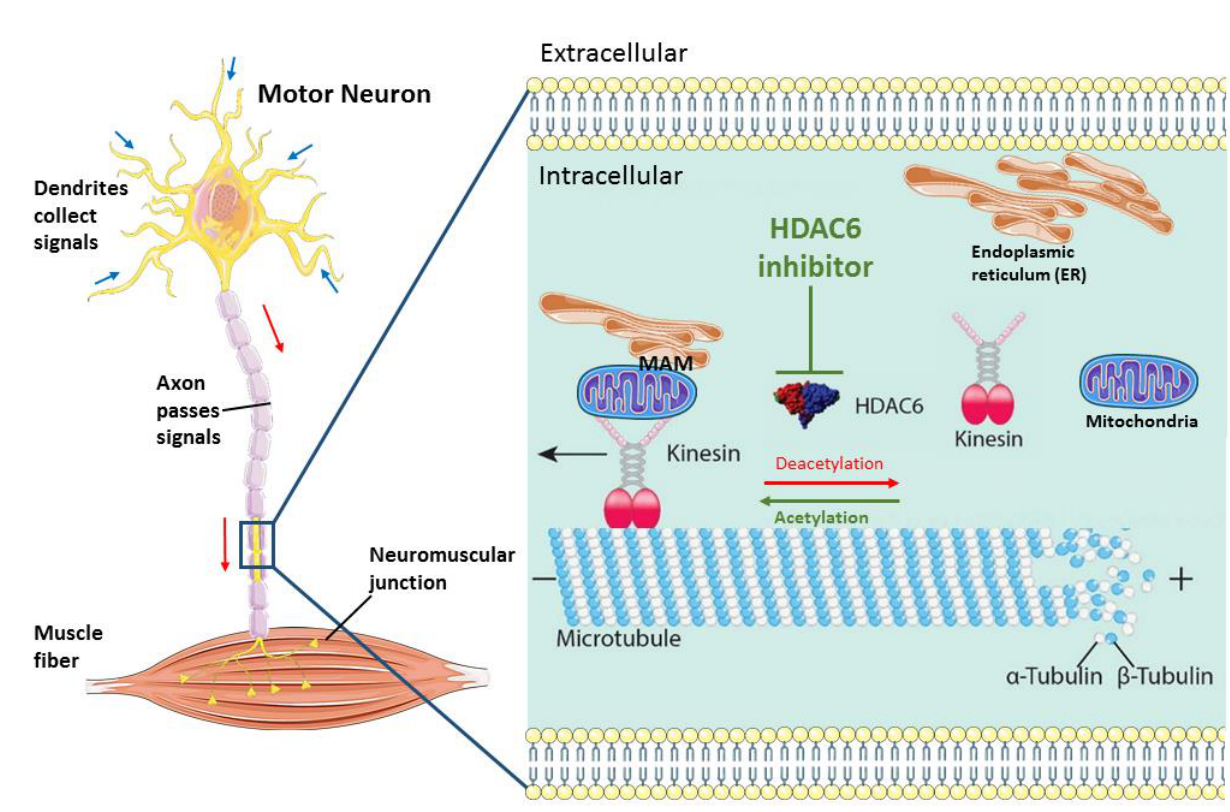
FIGURE 1: Schematic overview of the machinery of HDAC6 inhibition in rescuing axonal transport defects in ALS. Axonal transport cargoes, such as ER and mitochondria, anchored to the motor protein kinesin. The molecular motors kinesin travel along the microtubules with their bound cargoes in an anterograde direction. HDAC6 is an important regulator of axonal transport by regulating the acetylation state of α-tubulins which build up microtubules with β-tubulins. In stabilized microtubules, the minus end facing the soma and dynamic plus end facing the synaptic terminals. Under cell stress, the motor neuron start ‘dying back’ from the distal part of axon caused by insufficient metabolic supply. HDAC6 inhibition increase the acetylation level of microtubules and increase the localization of MAMs along microtubules and finally speed up axonal transport of ER and mitochondria. (This image is constructed based on the images from Servier Medical Art (http://smart.servier.com/) and Neurobiol Dis. 2017 Sep; 105:300-320.doi: